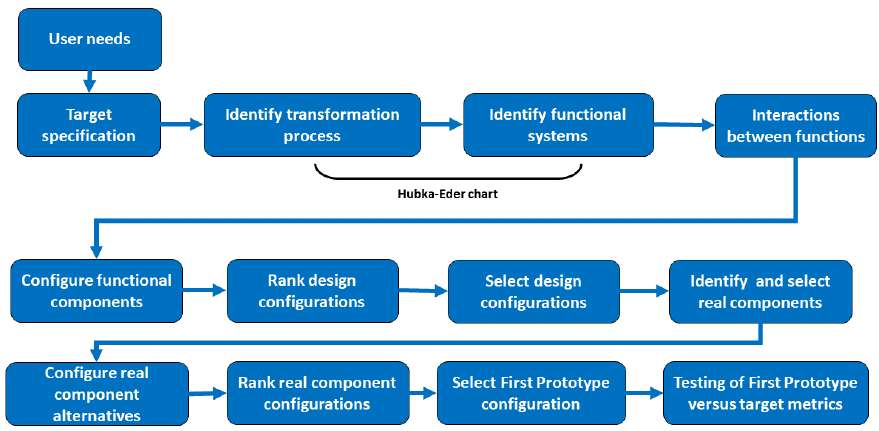
Figure 2. The workflow in conceptual design when developing a new product prototype as